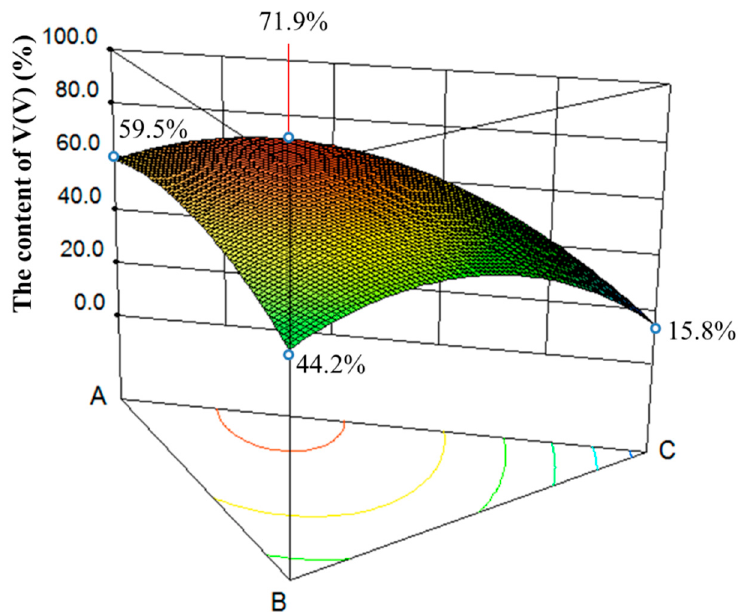
Figure 9. Response surface among NaCl, Na 2 SO 4 , and Na 2 CO 3 for V(V) of roasted slag.